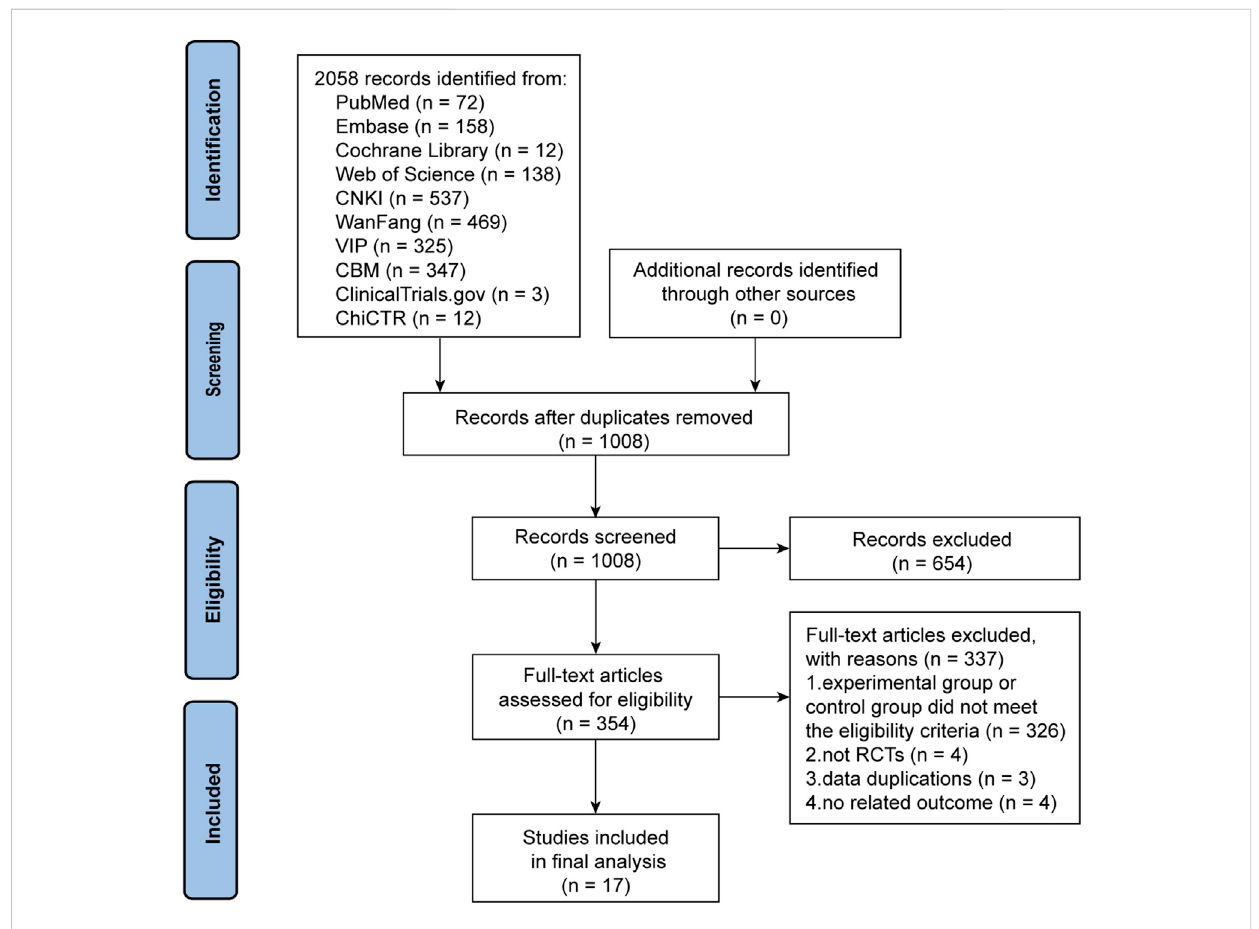
FIGURE 1 The PRISMA fl ow chart of the literature screening and selection